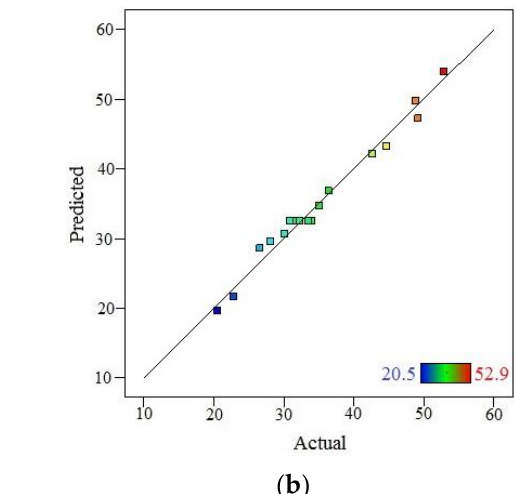
Figure 4. ( a ) Normal % probability plot of residuals for droplet density; ( b ) plot of actual vs. pre- dicted response for droplet density.